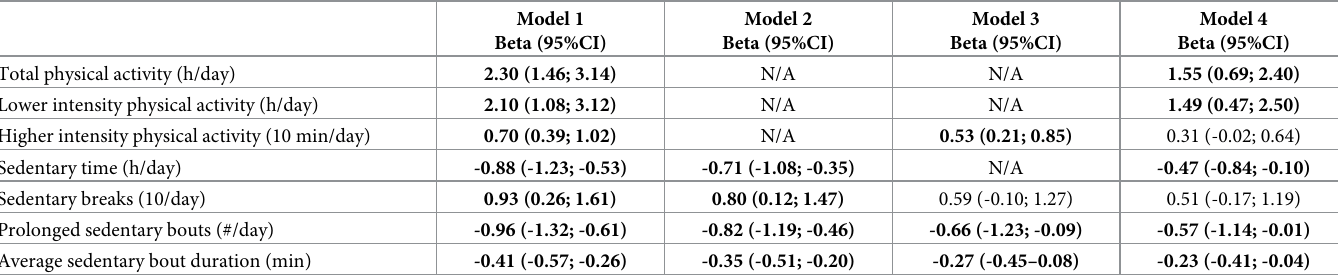
Table 3. Associations of physical activity and sedentary behavior variables with eGFR crcys